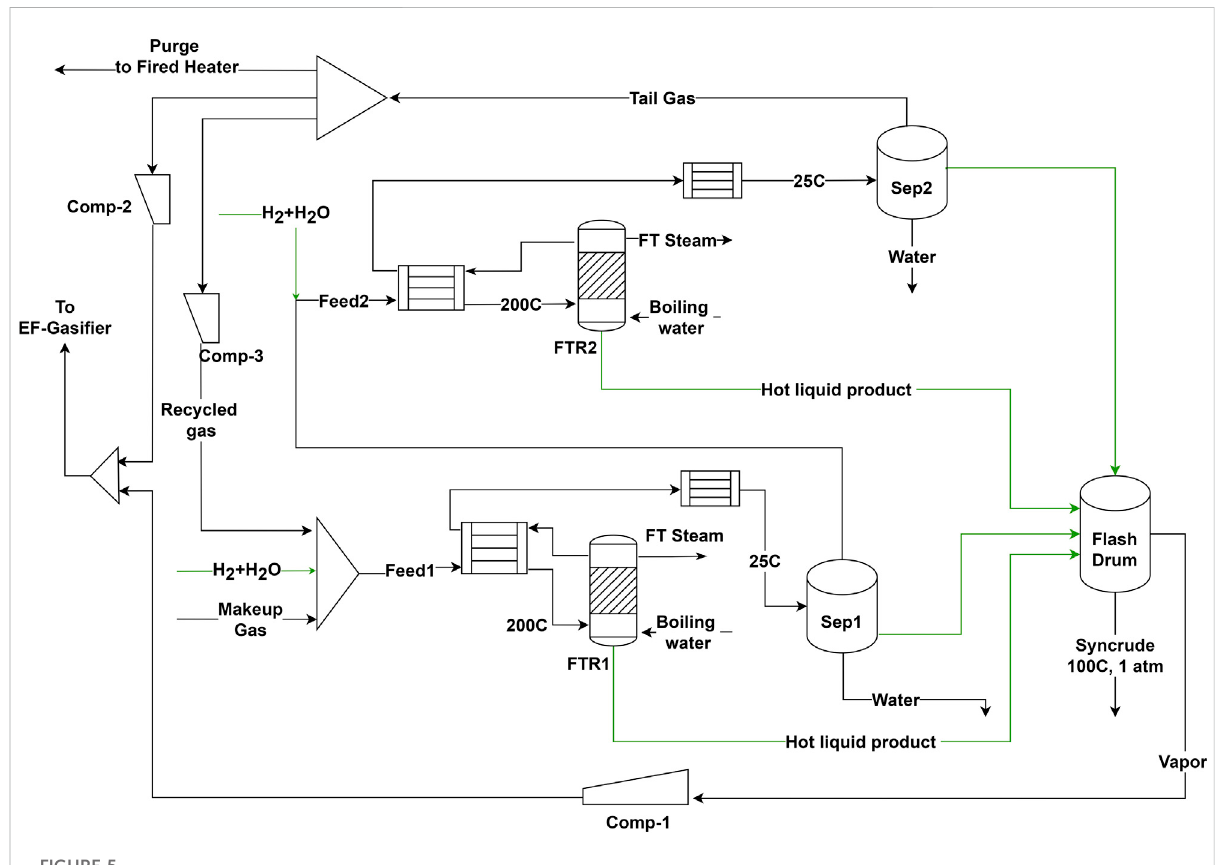
FIGURE 5 Process fl ow diagram of fuel synthesis process in Case V.